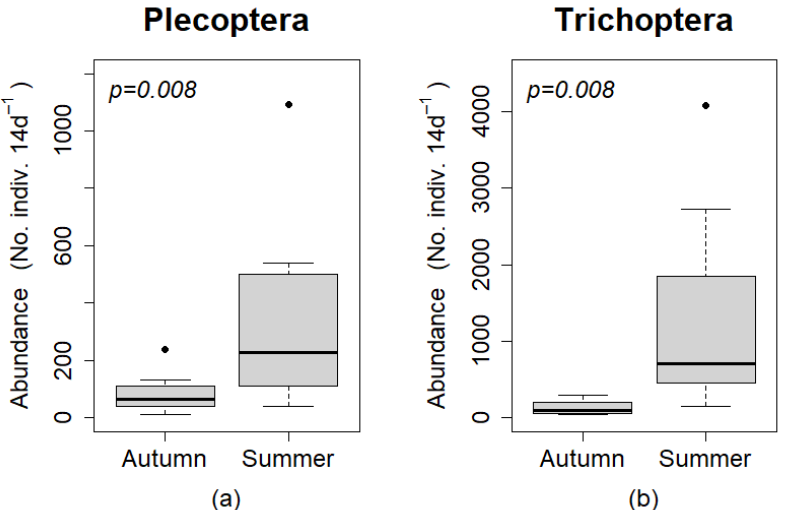
Figure 6. Box plots comparing abundances (No. individuals per 14 day period) of ( a ) Plecoptera, and ( b ) Trichoptera among sampling period. Boxes represent upper and lower quartiles, and whiskers extend to values no greater than or less than 1.5 times the inter-quartile range of the upper and lower quartiles, respectively. Points (•) are outliers outside the values of the whiskers. Statistical comparisons were performed using a Wilcoxon sign rank test.